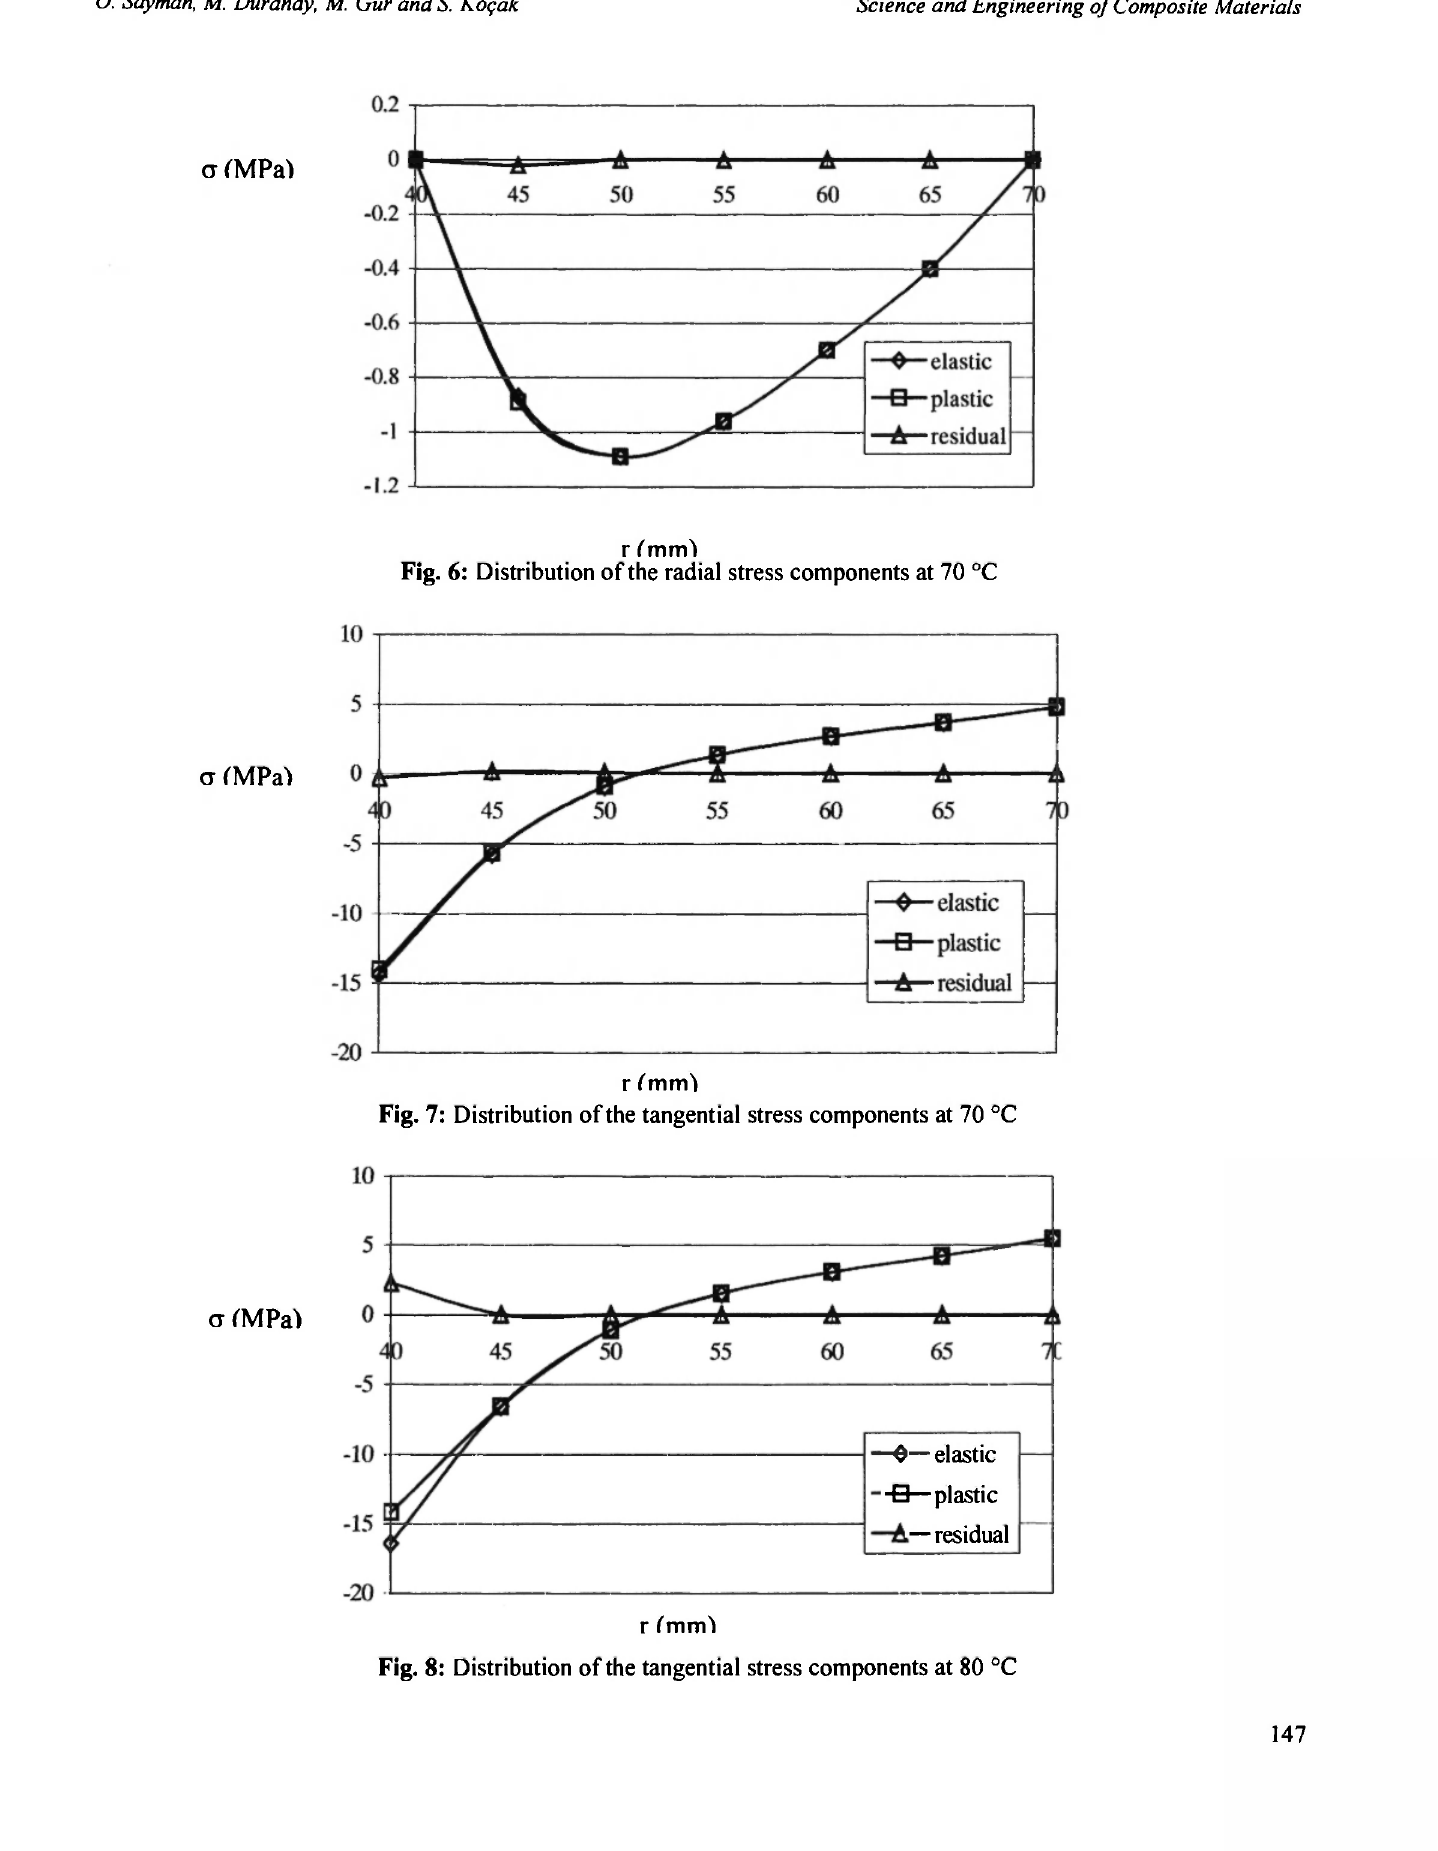
r (mm"> Fig. 6: Distribution of the radial stress components at 70 °C